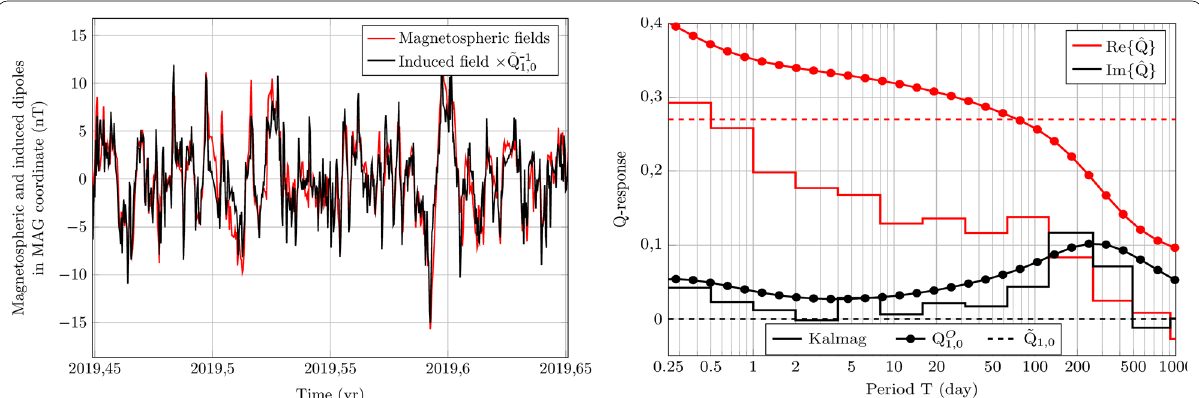
Fig. 11 Left: mean dipole component in magnetic coordinates and evaluated at a radius r = 6371.2 km of the sum of all magnetospheric sources (red line) and of the induced field rescaled by the inverse Q ‑response ˜ Q − 1 1,0 discussed in the manuscript (black line). Components associated with time periods larger than 15 days have been filtered out. Right: real (red) and imaginary (black) parts of the Q ‑response. Full lines: Kalmag solution estimated during the [2015, 2021] time interval and averaged over [ T i ,2 T i ] period intervals. Lines with circles: Q ‑response estimated by Olsen et al. (2005) with a 1‑D model of the conductivity within the Earth’s interior. Dashes: Q ‑response associated with a simplified 1‑D conductivity model of the Earth’s interior (see